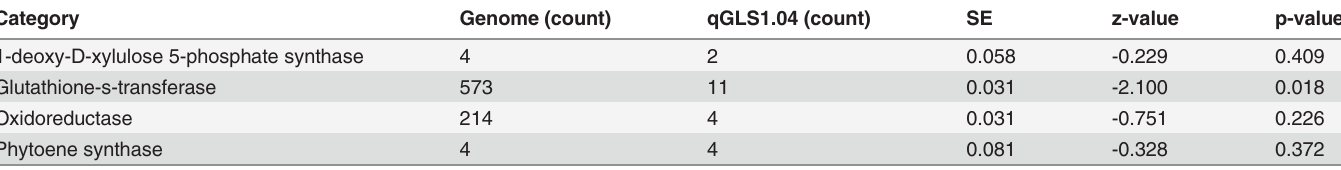
Table 5. Summary statistics for detoxi fi cation-related genes underlying qGLS1.04. Category